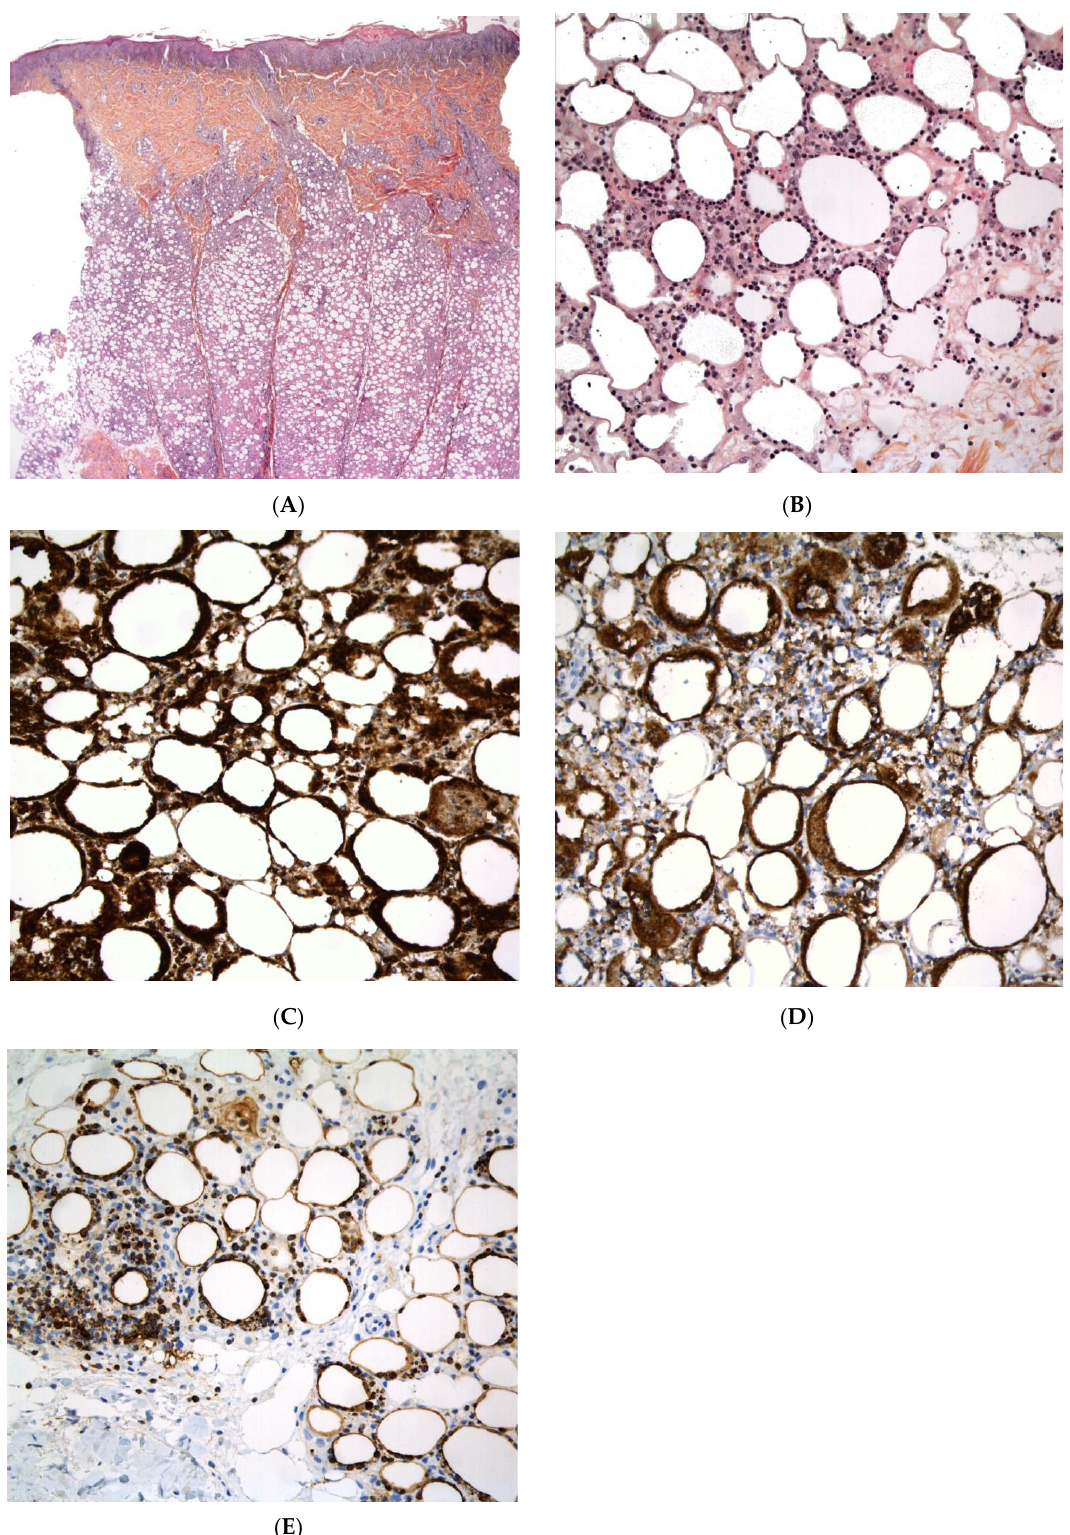
Figure 10. Cytotoxic T clonal panniculitis. ( A ) Lobular panniculitis with lymphoid cell infiltration (original magnification × 30). ( B ) Atypical lymphoid cells with adipocyte rimming and adipocyte necrosis showing infiltration by cells expressing ( C ) CD3, ( D ) Tia1, and ( E ) granzyme (original magnification ×